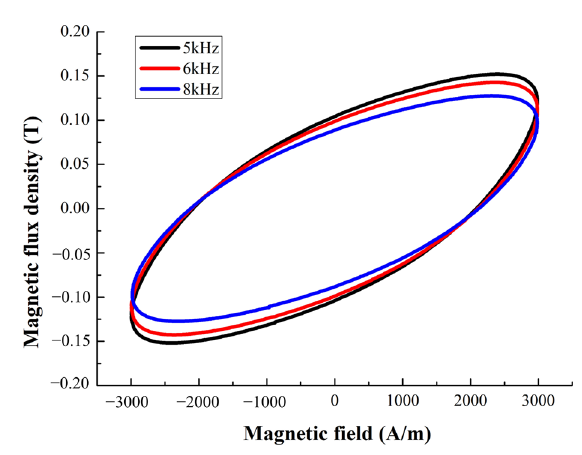
Figure 2. Dynamic-hysteresis curves at different frequencies.